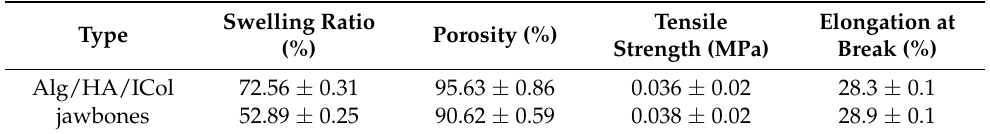
Table 4. Comparison of the structure and mechanical properties of Alg/HA/ICol and the jawbones scaffolds.